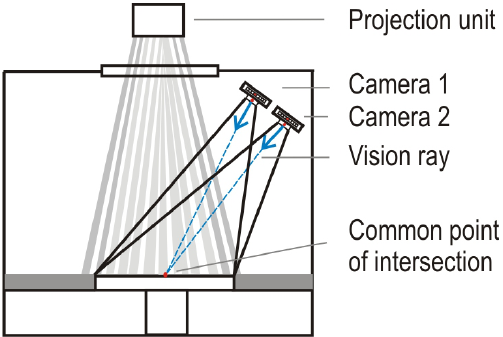
Figure 12. Principle of the fringe-projection technique used to analyze the PBF-LB/M process. A structured pattern is projected onto the powder bed by the projection unit. A stereo camera system (cameras 1 and 2) records this pattern. With the mathematical combination of the vision rays at a common point of intersection (sketched in blue as an example), an (x, y, z)-value of the surface can be obtained by triangulation for each pixel pair of the cameras. Reprinted with permission from Reference [53], where more information on the measurement principle can be